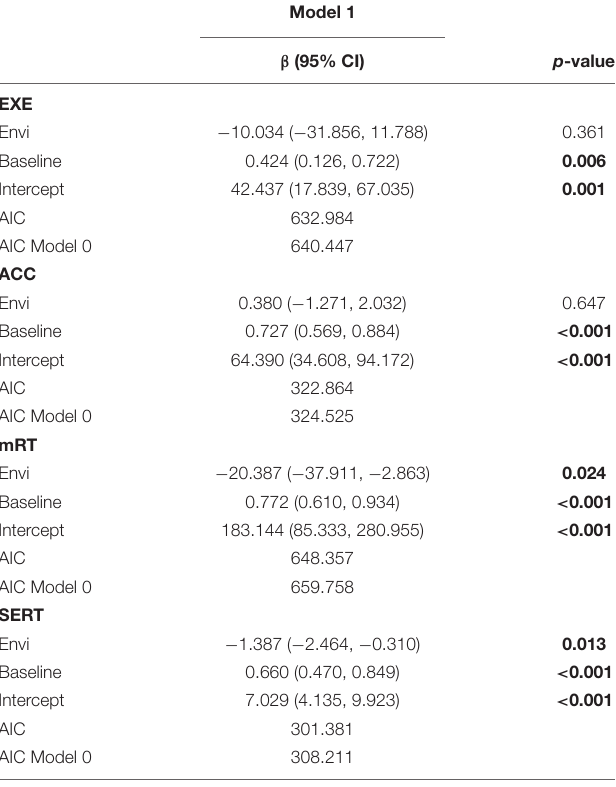
TABLE 3 | Linear mixed models exploring the effect of environment on Attention Network Performance in typically developing